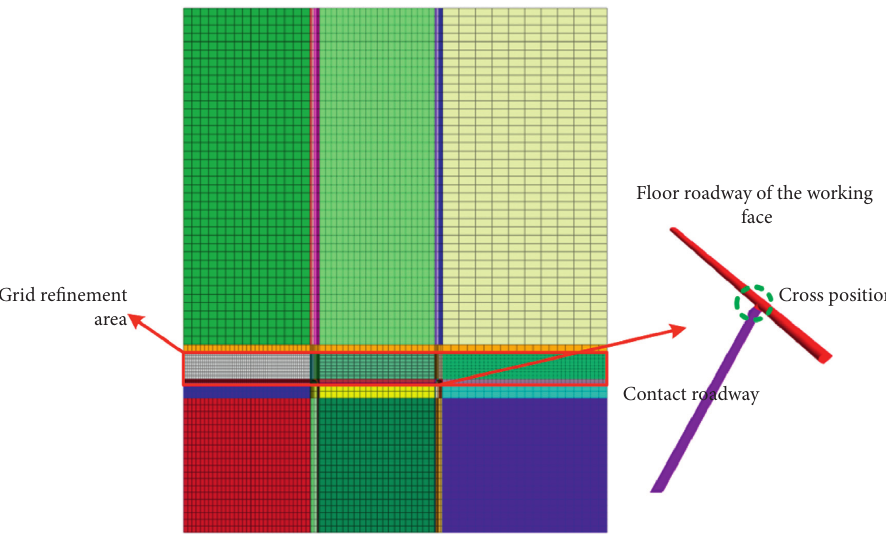
Figure 10: FLAC3D numerical analysis